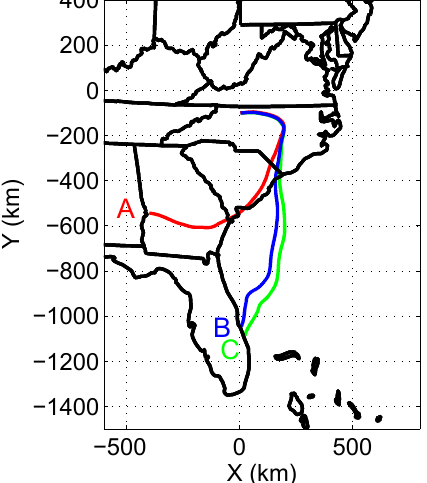
samples. The red and blue trajectories correspond to the samples on either side of a LCS. The blue and green trajectories correspond to the samples on one side of the same LCS. Sampling times are 13:40, 14:00 and 14:10UTC during the interrogation window (12:00 UTC 29 September to 12:00UTC 30 September 2010) for the red, blue and the green particles, respectively. Source points of the collected particles are shown by A, B and C. The integration time for all three particles is T =